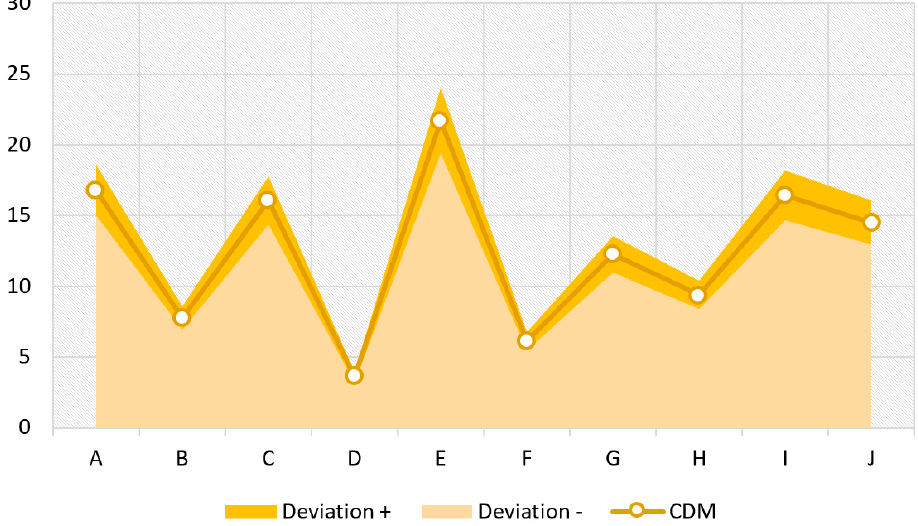
Figure 1. Forecasted indicators of financial competitiveness level of the surveyed companies (CDM) for 2021. Source: generated by the authors.